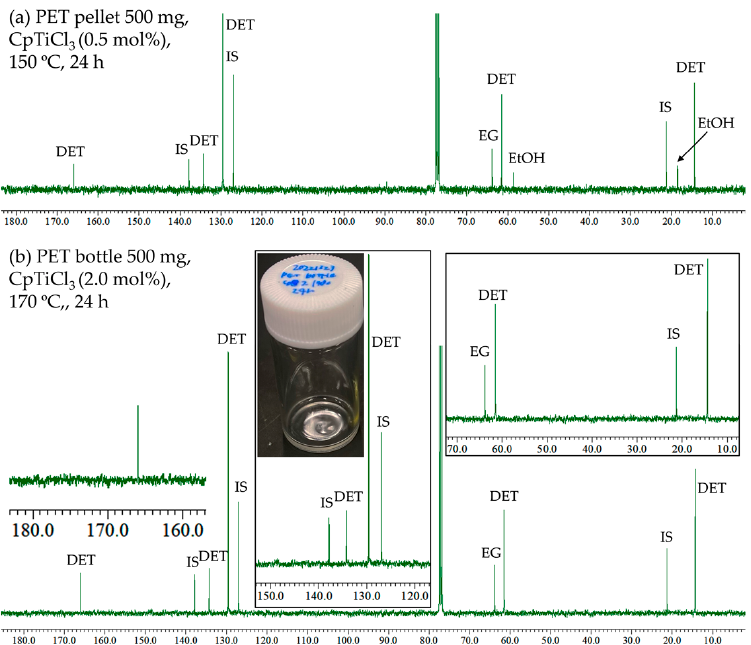
Figure 5. 13 C NMR spectra (in CDCl 3 at 25 °C) for transesterification of PET with ethanol by CpTiCl 3 . Conditions: ( a ) PET pellet 500 mg, ethanol 5.0 mL, CpTiCl 3 (0.5 mol%), 150 °C, 24 h (run 12). ( b ) PET sheets (from the drinking bottle) 500 mg, ethanol 5.0 mL, CpTiCl 3 (2.0 mol%), 170 °C, 24 h (run 16).